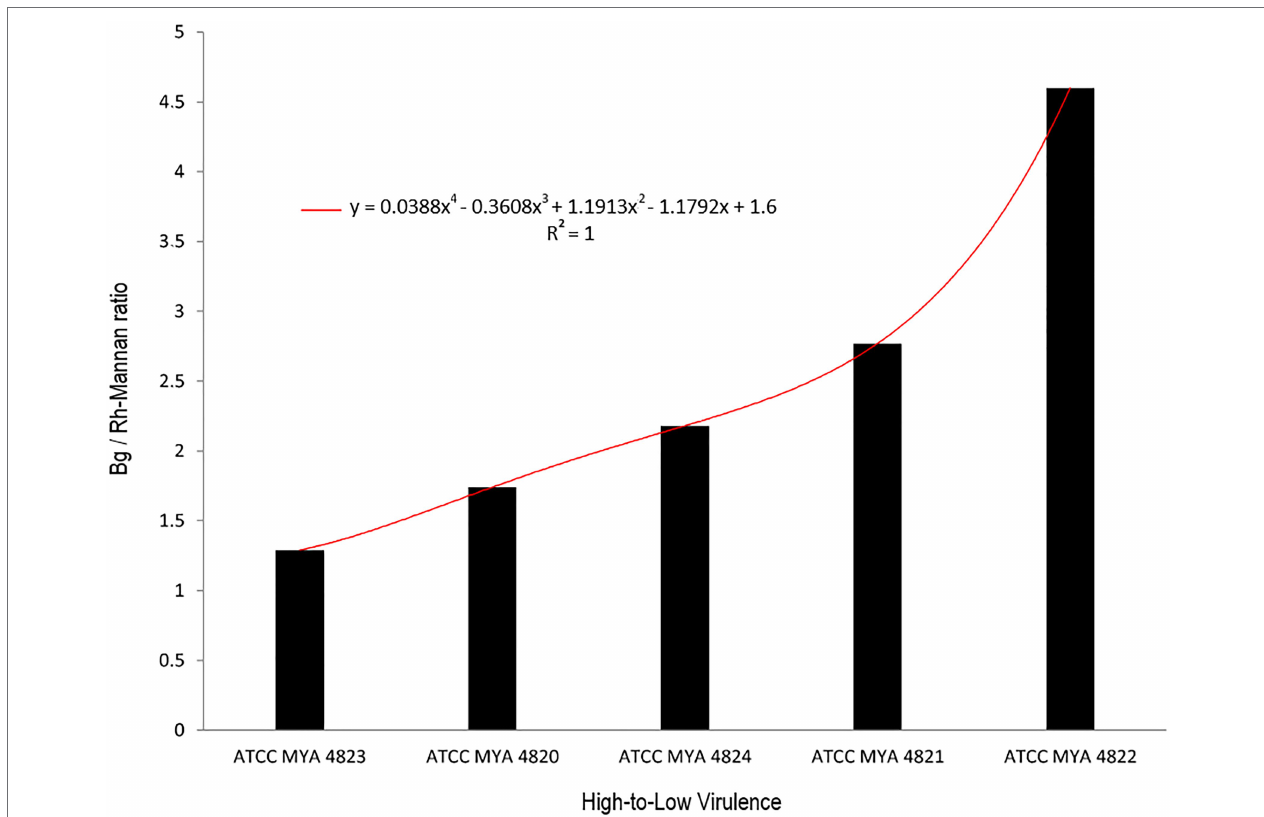
FIGURE 6 | Relation between β glucan vs. rhamnomannan ratio with strain virulence. Black columns represent the ratio of β glucan to rhamnomannan present in the cell wall. Strains are arranged from higher to the lower virulence reported. The red curve represents the polynomial curve of relationship, mathematically represented by an ascendant curve with an R 2 = 1 with the polynomial function y = 0.0388 x 4 –0.3608 x 3 + 1.1913 x 2 –1.1792 x + 1.6. Bg, β -glucan; Rh-Mannan,